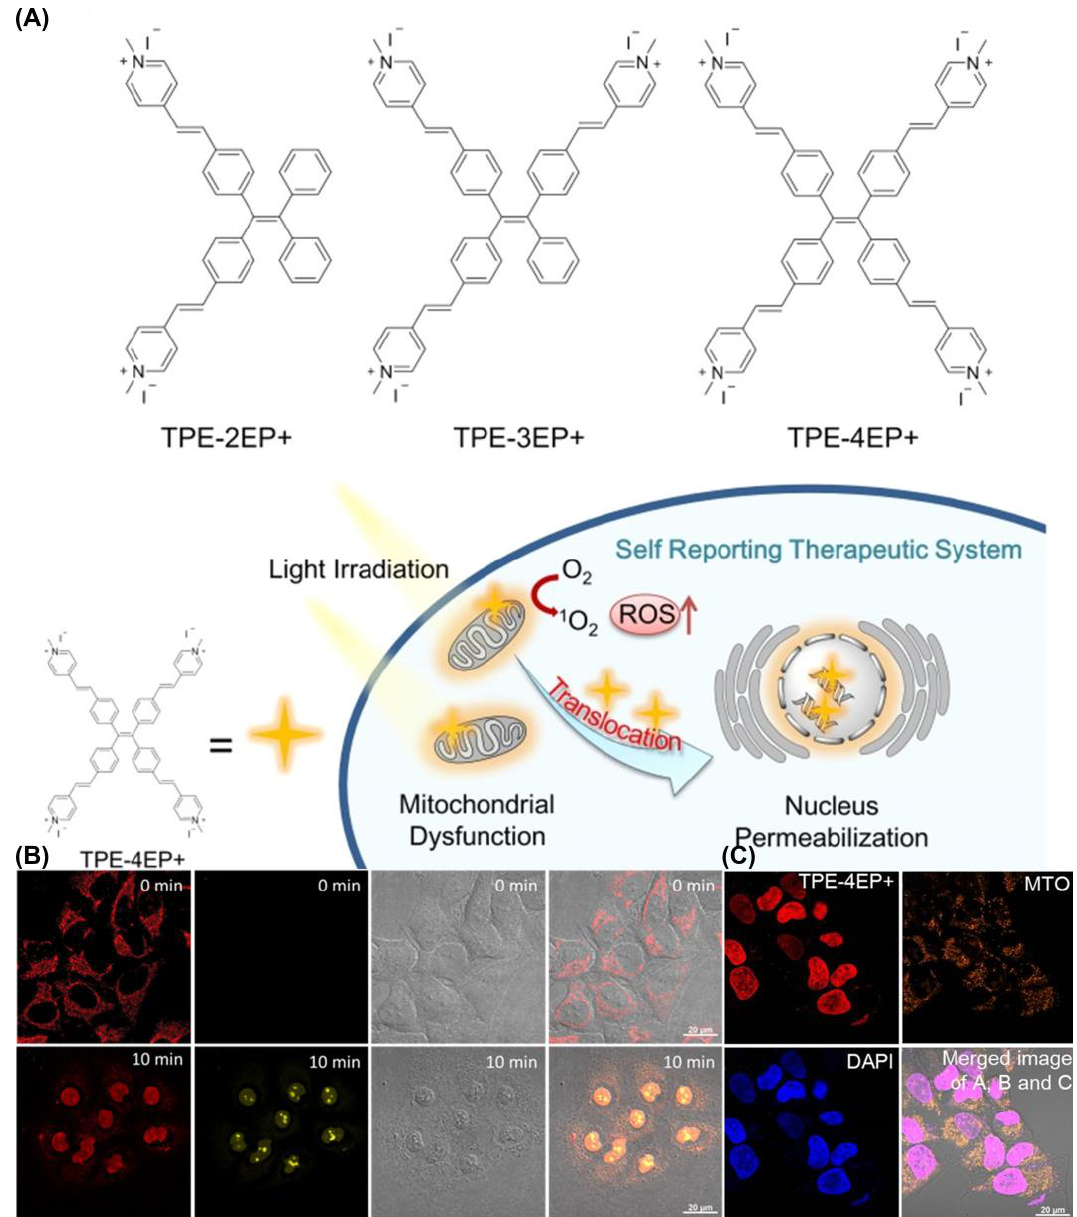
Figure 18. ( A ) Molecular structures and mechanism of mitochondria-to-nucleus translocation of TPE-4EP+; ( B ) mitochondria-to-nucleus translocation images of HeLa Cells stained with TPE-4EP+; ( C ) colocalization experiments of HeLa Cells co-incubation with TPE-4EP+. Reprinted with permission from Ref. [131]. Copyright 2019 American Chemical Society.